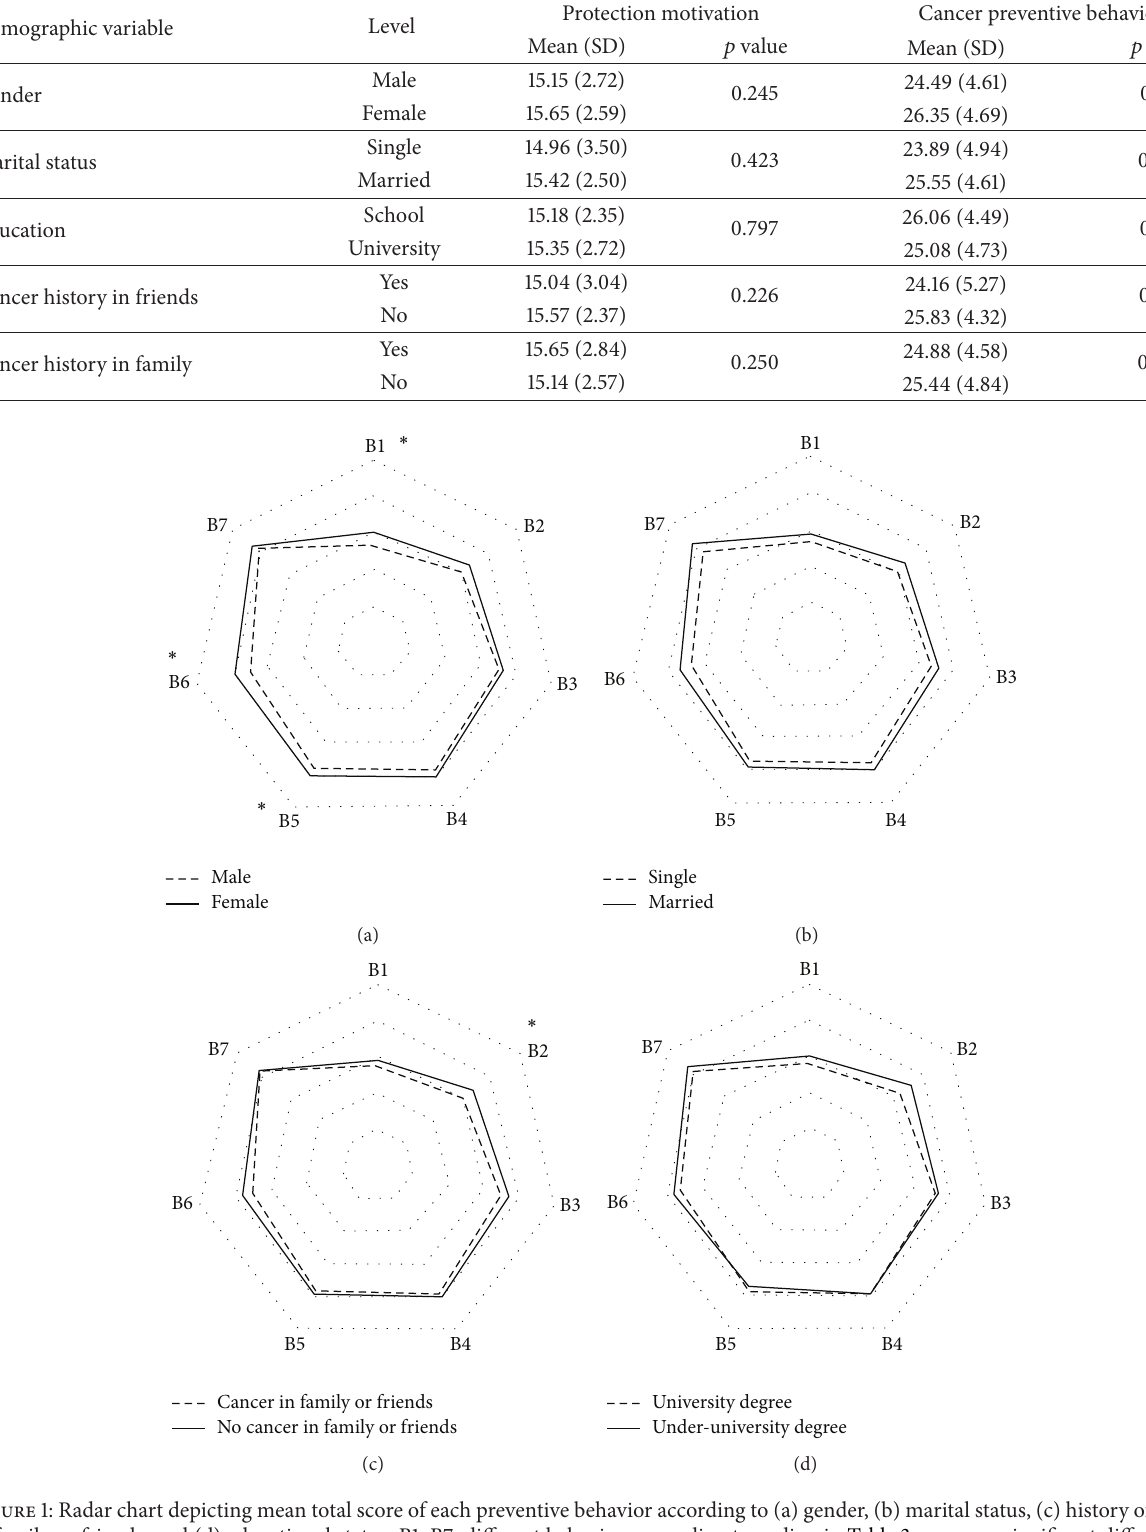
Table 5: Comparison of the protection motivation mean score and cancer preventive behaviors based on some demographic variables ( 𝑛 = 161 ).